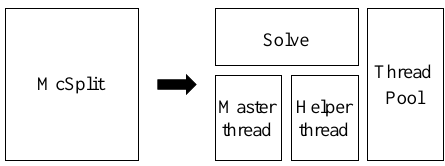
Figure 4. Partitioning the original MCS function to parallelize